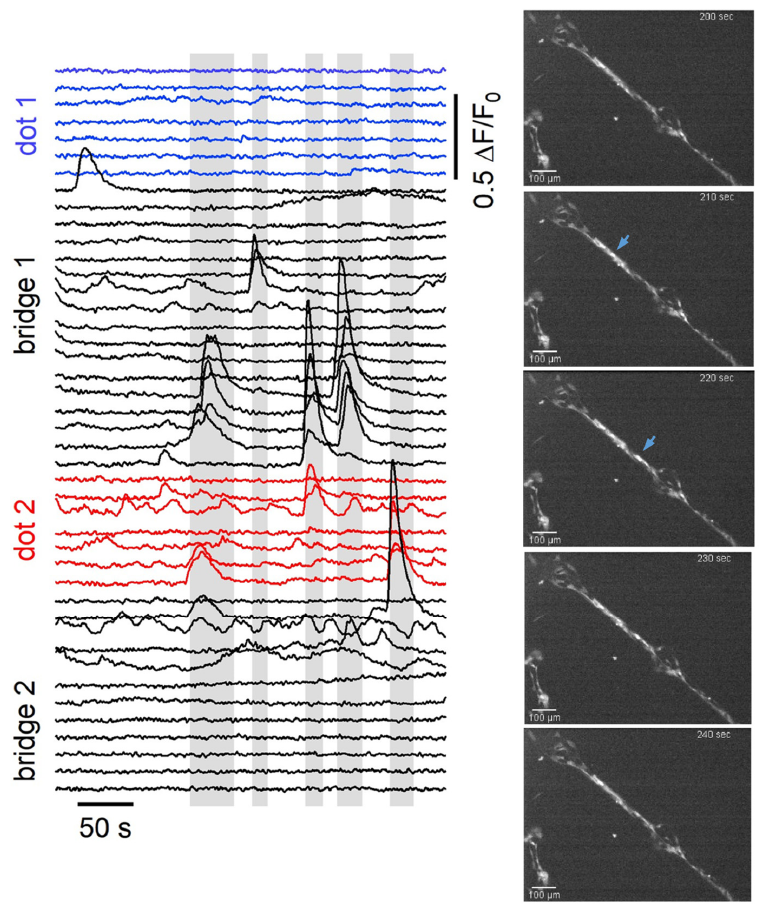
Figure 7. On the left are the calcium intensity traces ( ∆ F/F) of cells cultured on micropatterns as a function of time. Different colours indicate the different location of the cells corresponding to the traces. The grey bars highlight the calcium wave events, which can be recognised as the groups of intensity peaks on different cell traces. On the right are representative snapshots of a time-lapse video recording of spontaneous calcium activity of astrocytes cultured on micropatterned 15-nm-rough zirconia substrate. The video they are extracted from is reported in Supplementary Materials (Video S5).